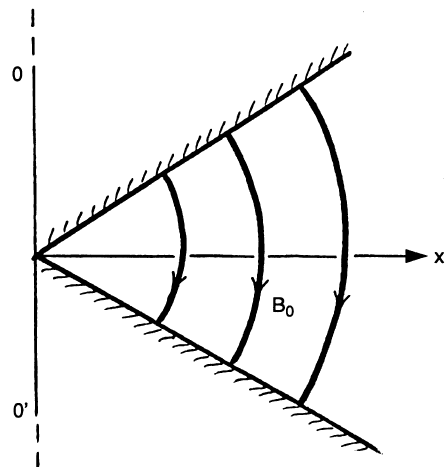
Fig. 15. A schematic plot of the geometry of the inner plasmasphere, used in the model calculation of ULF meridional